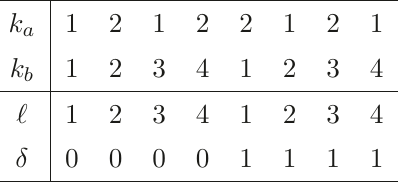
Table 2 . Assignment of ( ℓ, δ ) to ( k a , k b ) for U(2)